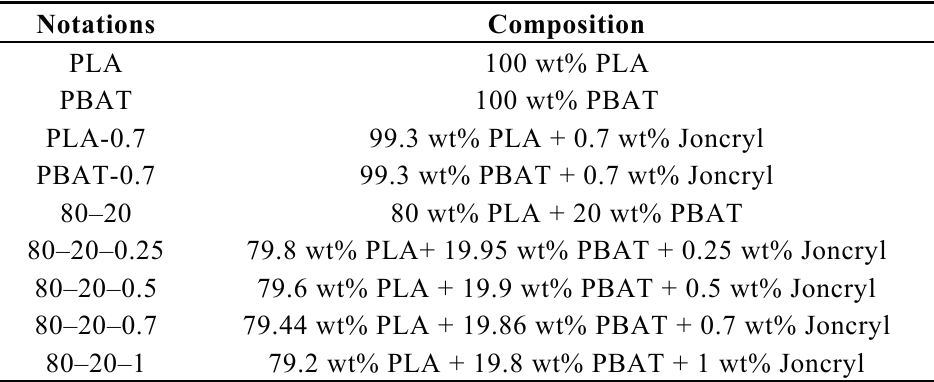
Table 1. Composition of the different studied